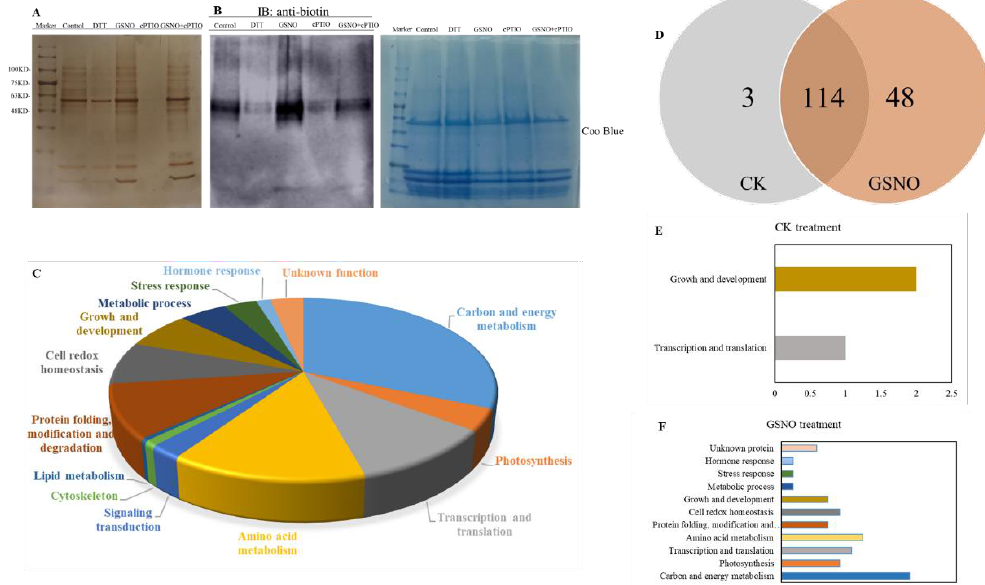
Figure 4. Identification of S -nitrosylated proteins during the development of adventitious rooting. Total S -nitrosylated proteins were detected through liquid chromatography / mass spectrometry / mass spectrometry (LC-MS / MS) and the western blotting method after explants were incubated with distilled water (CK) or 50 µ M GSNO, 200 µ M cPTIO, or 50 µ M GSNO + 200 µ M cPTIO for 6 h ( A, B ). Functional categorization of S -nitrosylated proteins from CK, GSNO and GSNO + cPTIO treatment ( C ). The number of S -nitrosylated proteins in CK and GSNO treated explants ( D ). Functional categorization of S -nitrosylated proteins from CK treatment alone ( E ). Functional categorization of S -nitrosylated proteins from GSNO treatment alone ( F ). Table 1. S -nitrosylated proteins identified from the control, S-nitrosoglutathione (GSNO), and GSNO + 2-(4-carboxy-2-phenyl)-4, 4, 5, 5-tetramethylimidazoline-1-oxyl-3-oxide (cPTIO) treatment during adventitious rooting of cucumber seedlings.